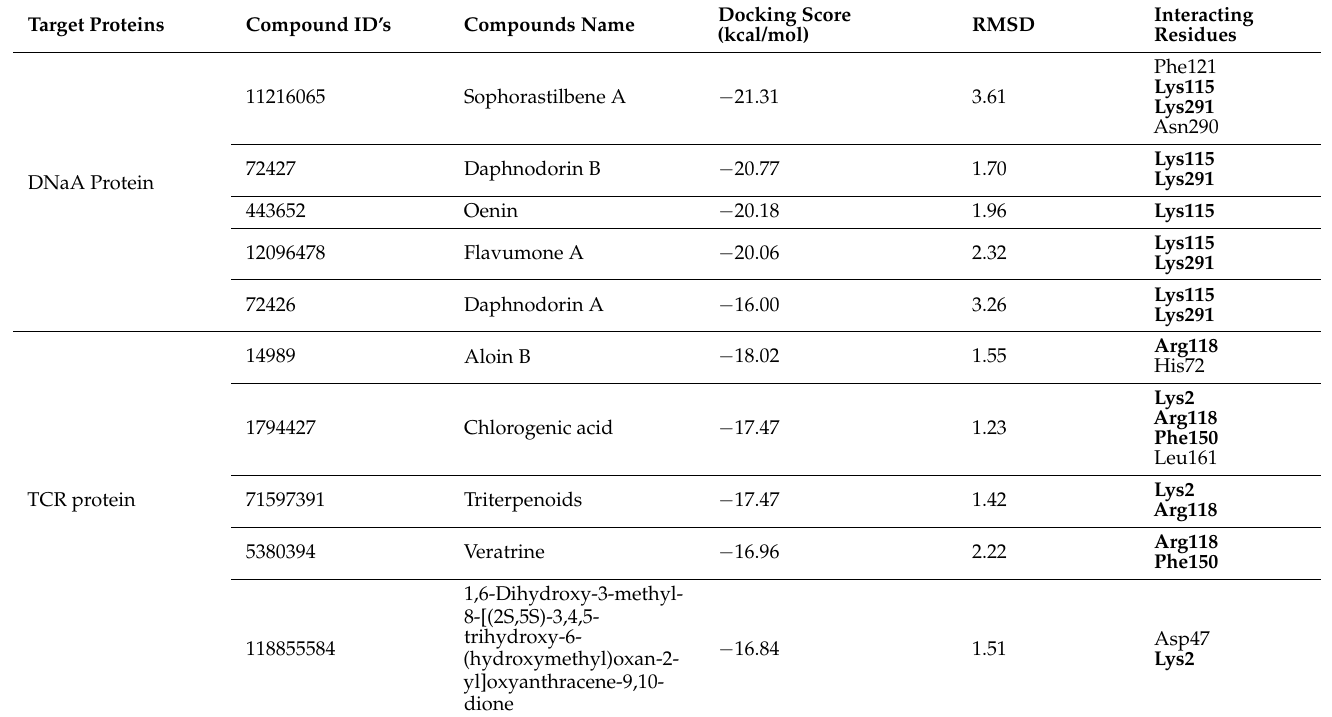
RMSD : Root Mean Square Deviation; Bold Interacting Residues indicate that all the compounds are hitting the common